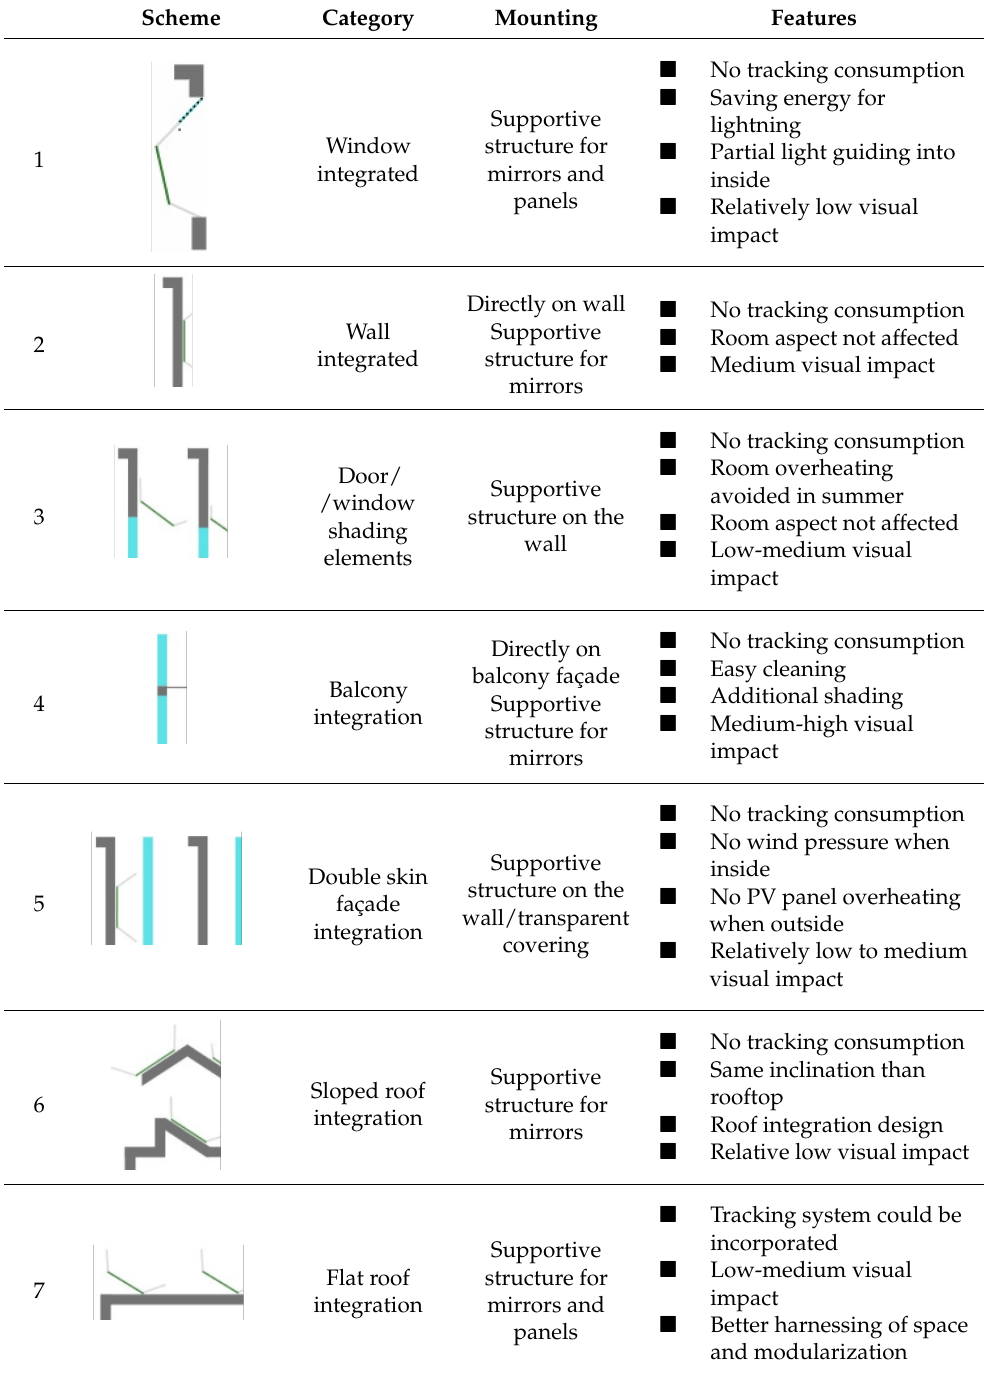
Table 1. Options for building integration of mirrored PV